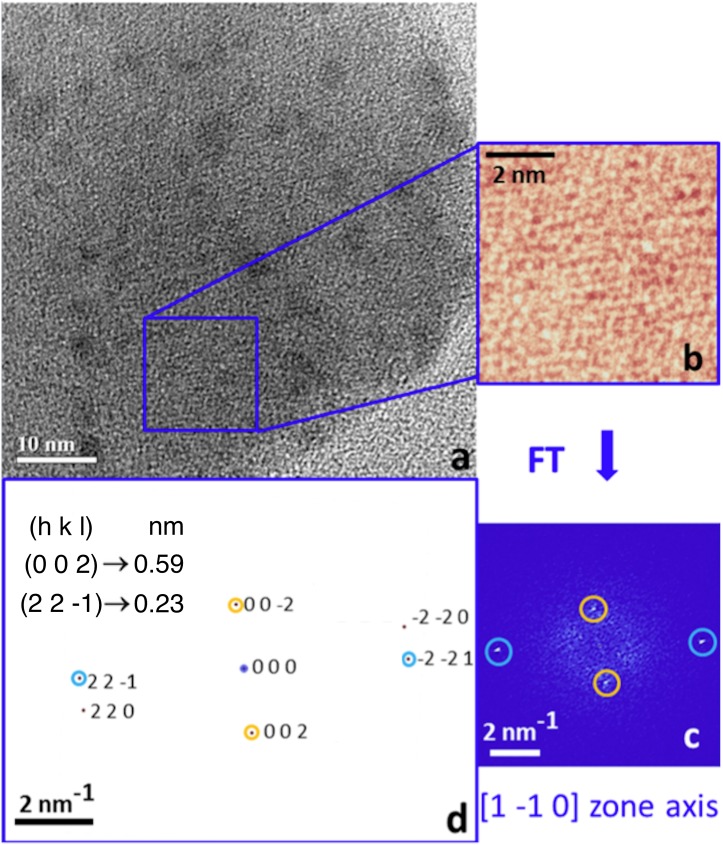
Characterization of creatinine particles a): HRTEM image; b): magnified view of the square region marked in a); c): diffractogram of b); d): simulation of the diffraction pattern of creatinine in [1–10] zone axis with reported the lattice spacing relevant to the observed intensities. The yellow and pale-blue circles in the diffraction pattern simulation mark the corresponding circles around the experimental spots in c).